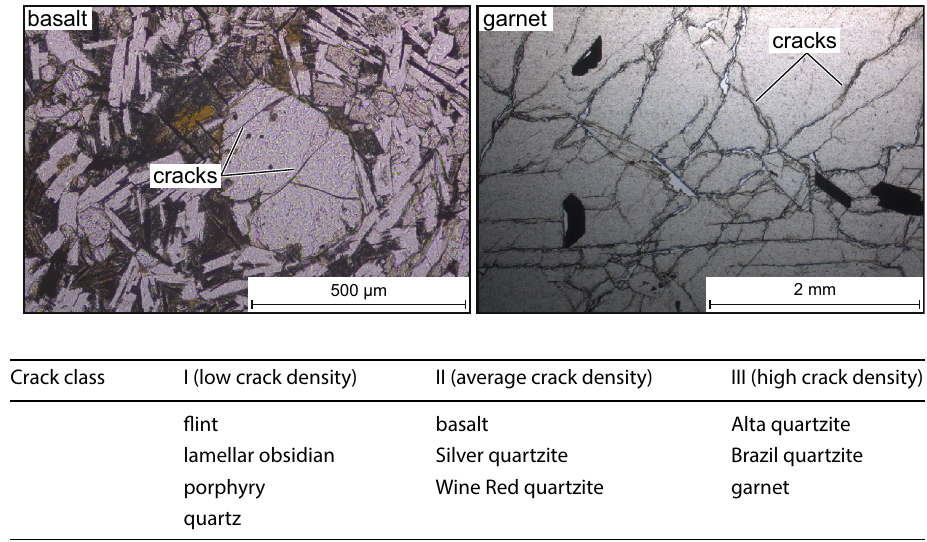
Table 8 Crack classes of the rock samples